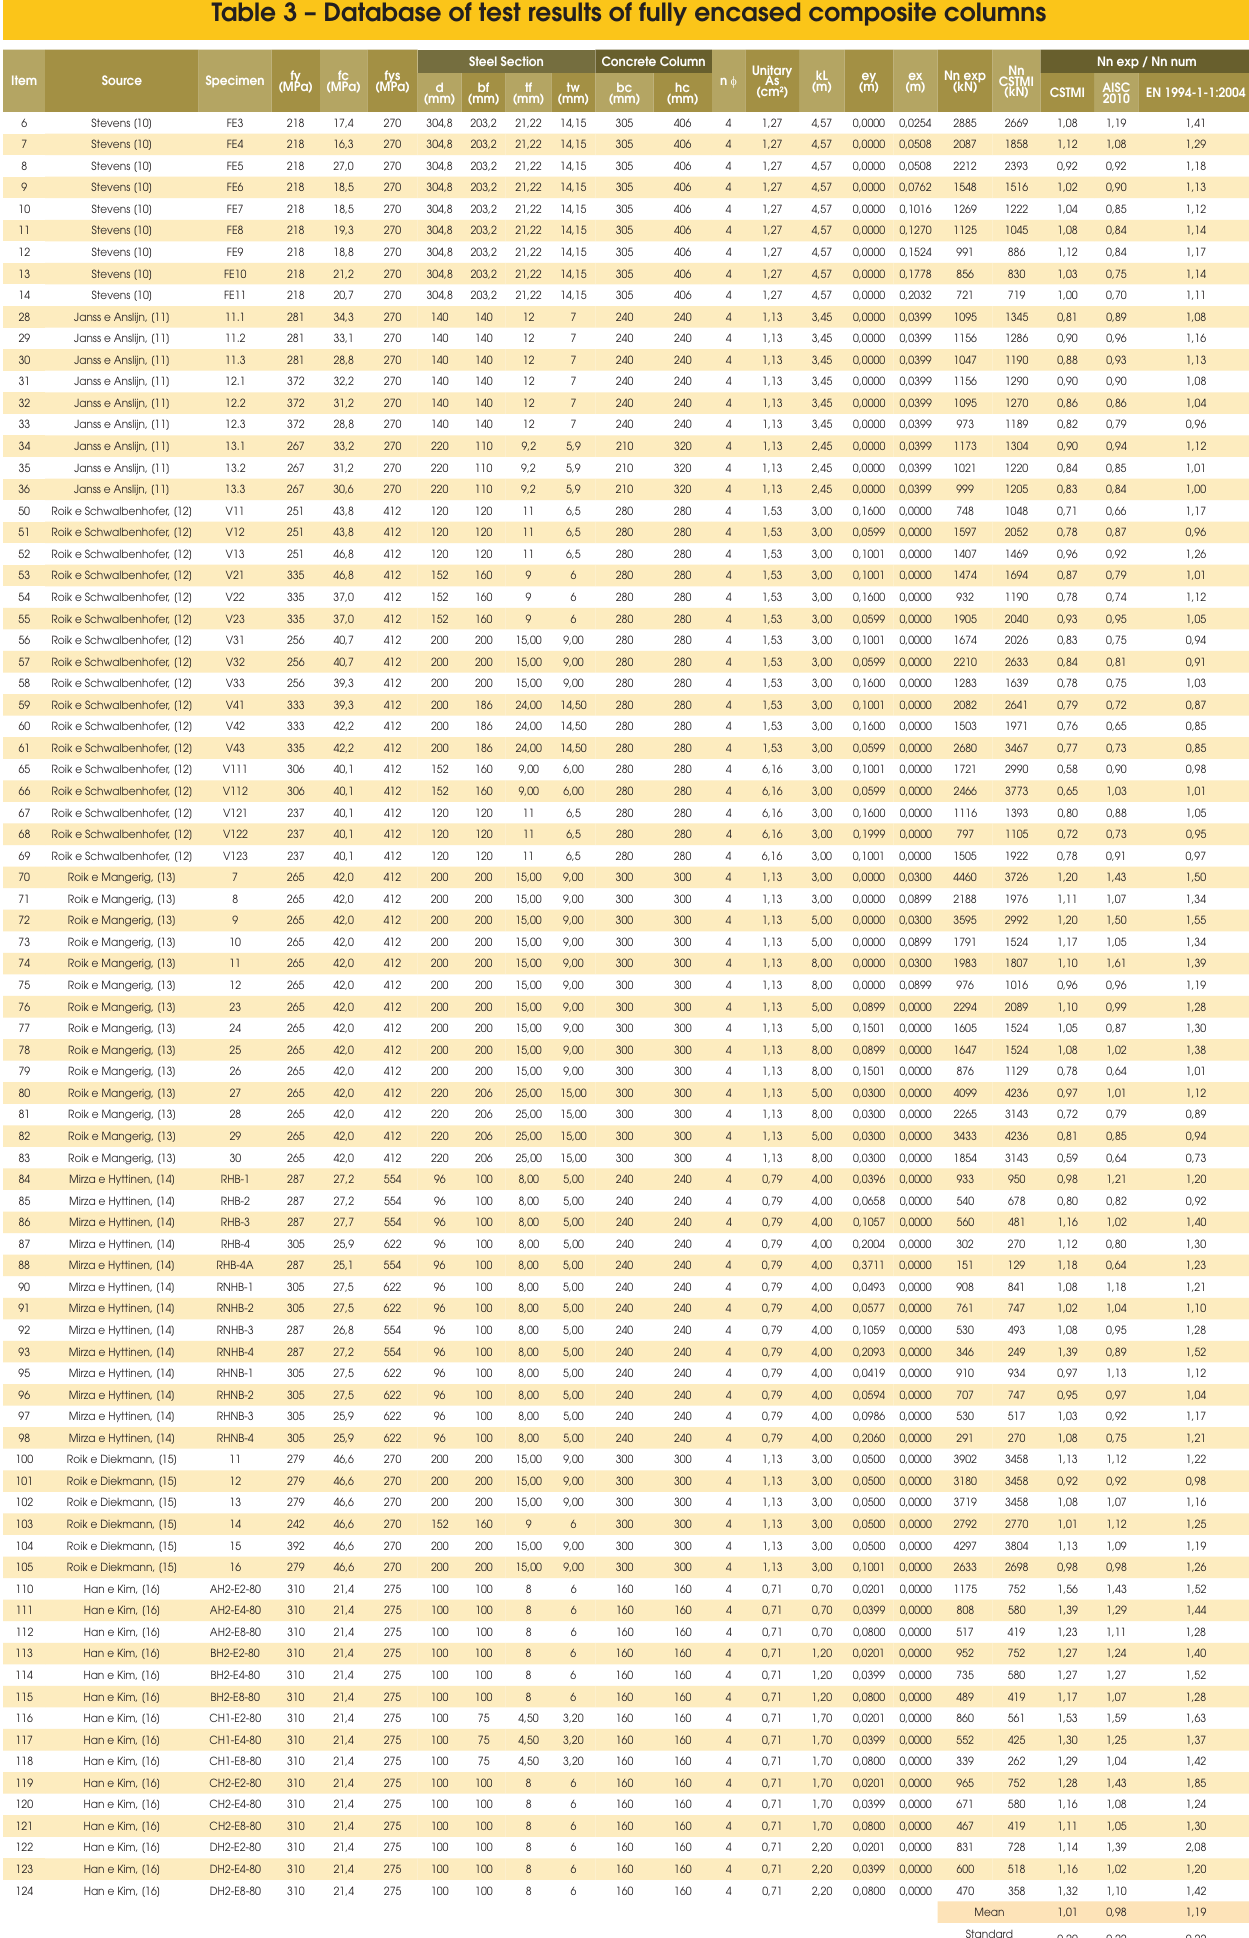
Table 3 – Database of test results of fully encased composite